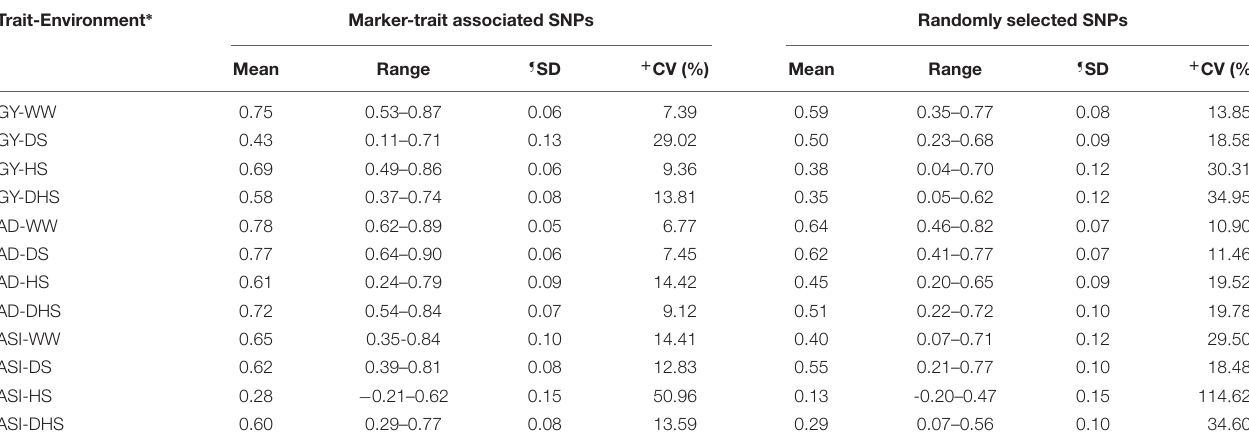
TABLE 3 | The genomic prediction accuracies ( r MG ) of the 12 trait-environment combinations using two kinds of marker density of marker-trait associated SNPs, and randomly selected SNPs filtered with minor allele frequency greater than 0.05 and 0%